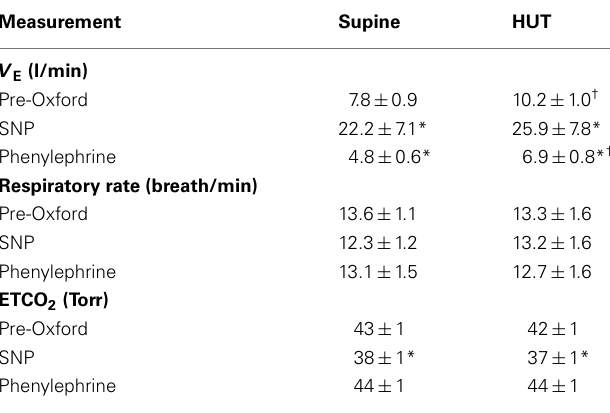
Table 2 | Supine and upright respiratory data pre-Oxford, after SNP bolus, and after